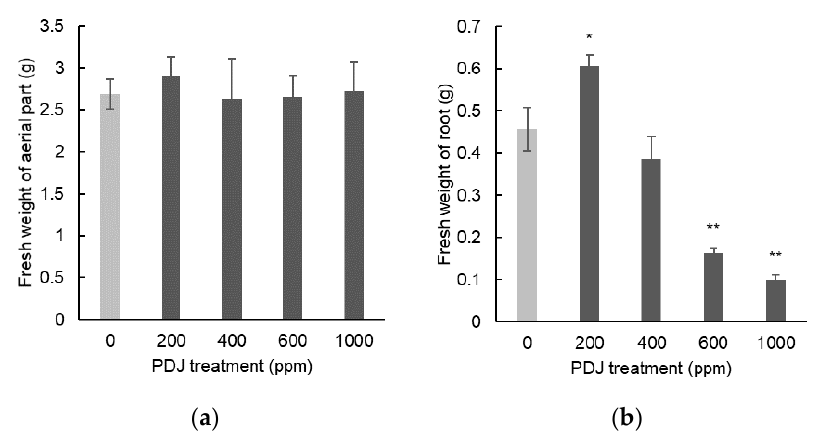
Figure 2. Weights of aerial parts ( a ) and roots ( b ) of komatsuna treated with PDJ applied drip-wise at various concentrations. Komatsuna seeds were germinated and grown in soil. PDJ at 200, 400, 600, and 1000 ppm was applied to seedlings at 1 week before harvest. Weight of aerial parts ( a ) and root weight ( b ) are average values ( n = 4) measured on the final day of pot culture (day 21). Error bars indicate standard error (SE). Asterisks (* and **) indicate statistically significant difference in comparison to the control using t-test at p < 0.05 and p < 0.01, respectively.